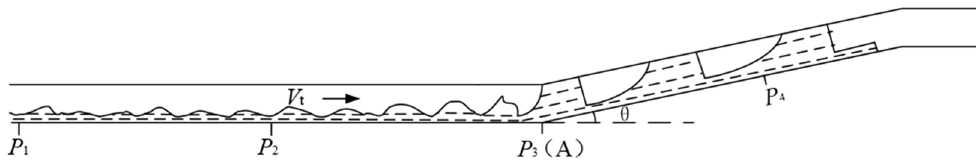
Figure 6. Pipeline pressure detection distribution.